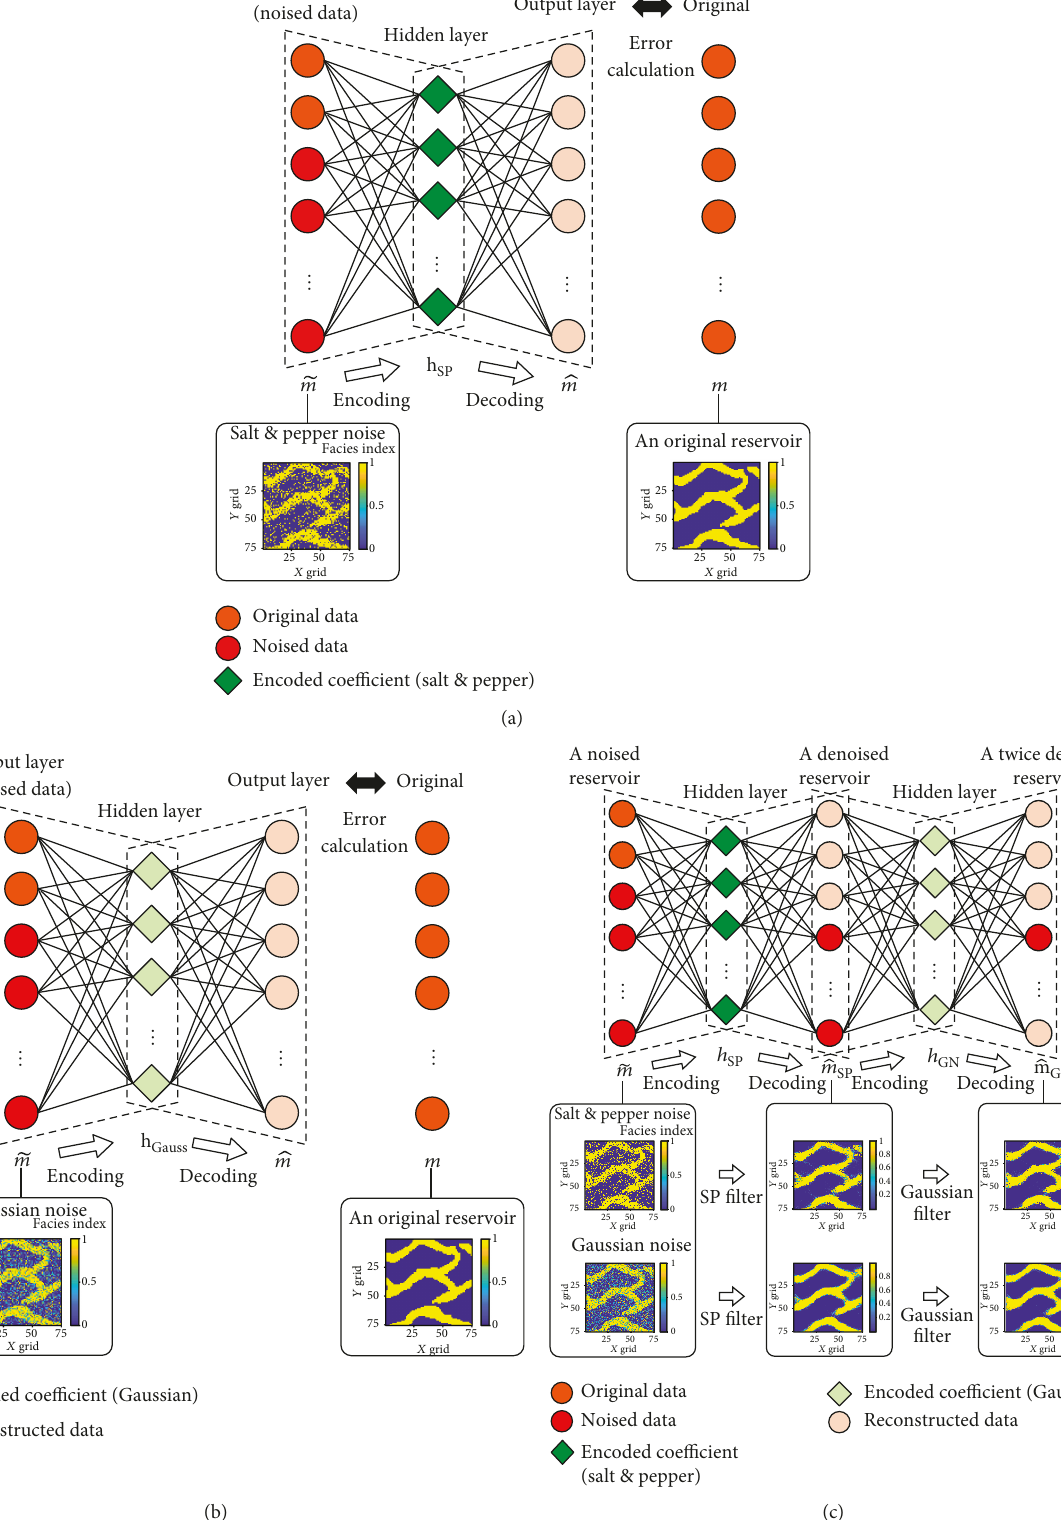
Figure 5: (a) A denoising autoencoder eliminating salt and pepper noise. (b) A denoising autoencoder eliminating Gaussian noise. (c) A serial denoising autoencoder with the original, noise, and puri fi ed reservoir